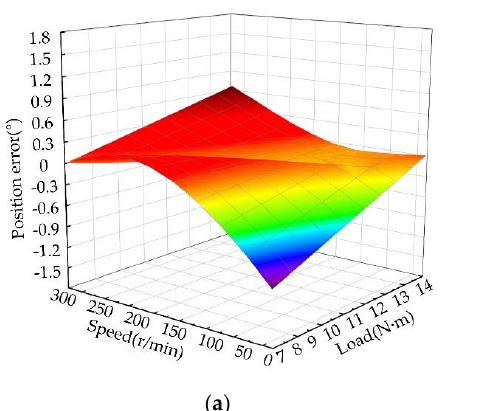
Figure 14. Results within 300 r/min: ( a ) Rotor position error at different speeds and loads; ( b ) Wave- form of center frequency f cA variation.